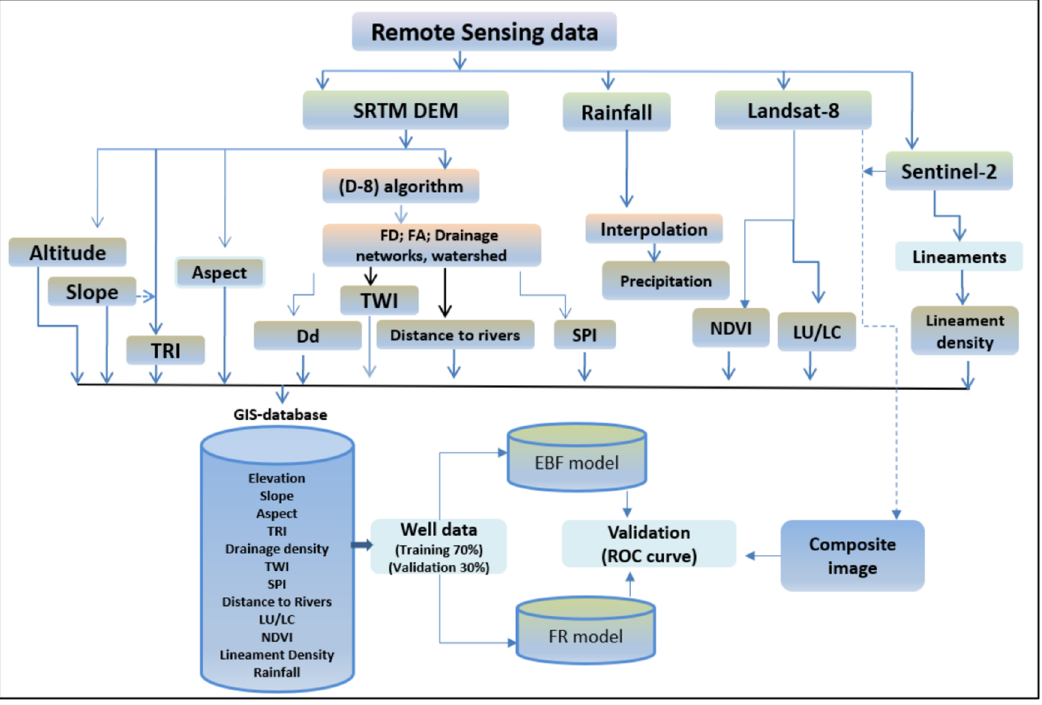
Figure 2. Data and methods used in present study.